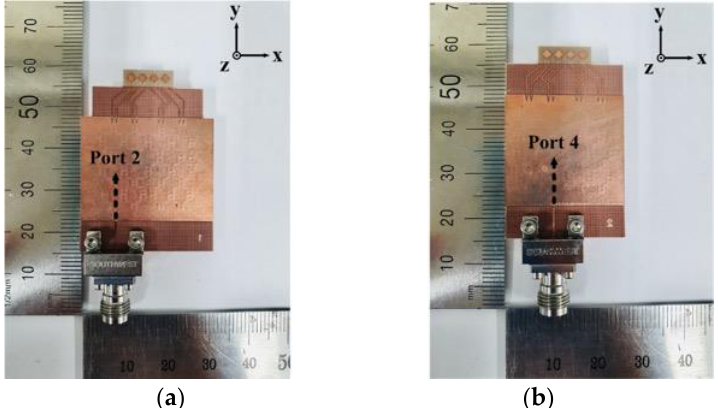
Figure 16. Fabricated prototypes of the antenna: ( a ) port 2 model and ( b ) port 4 model.